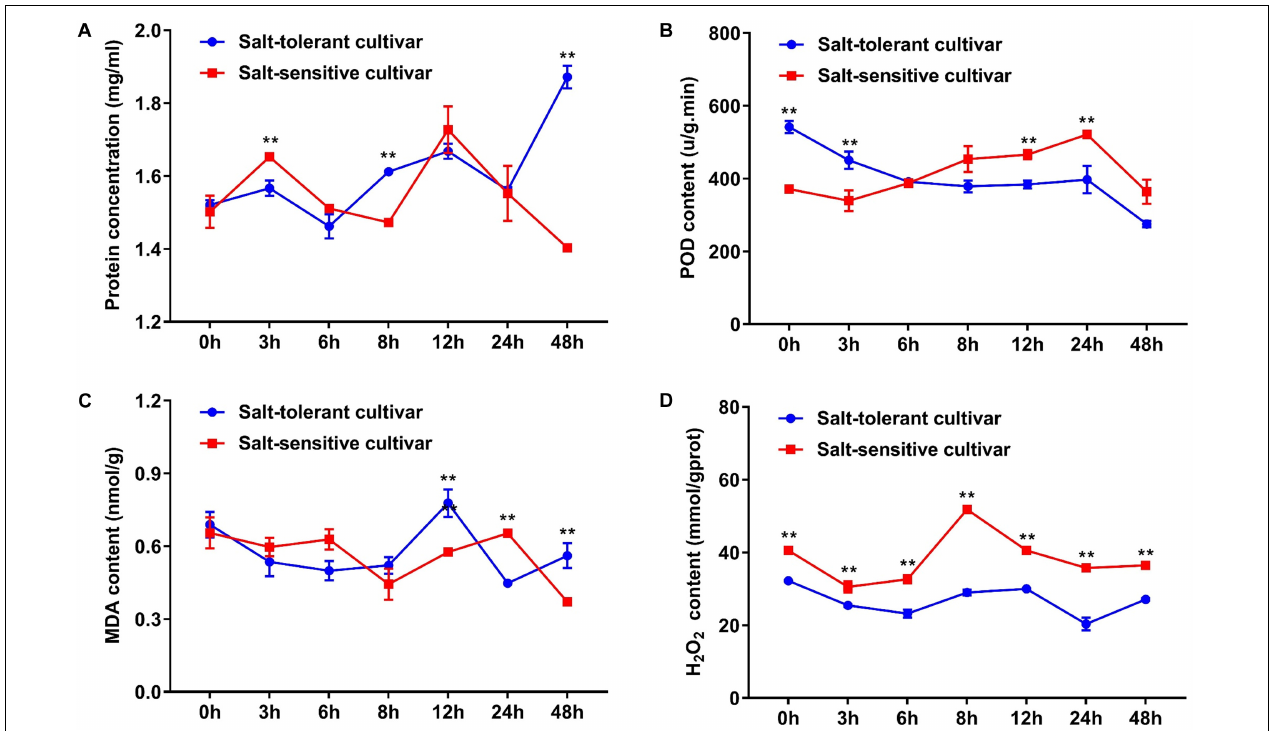
FIGURE 6 | Comparison of the protein, POD, MDA, and H 2 O 2 contents between the salt-tolerant cultivar and the salt-sensitive cultivar under salt stress. (A) Protein concentration. (B) POD content. (C) MDA content. (D) H 2 O 2 content. ∗∗ indicates significance at P < 0.01 level (two-tailed t -test). Error bars indicate ± SD; n = 3 independent biological